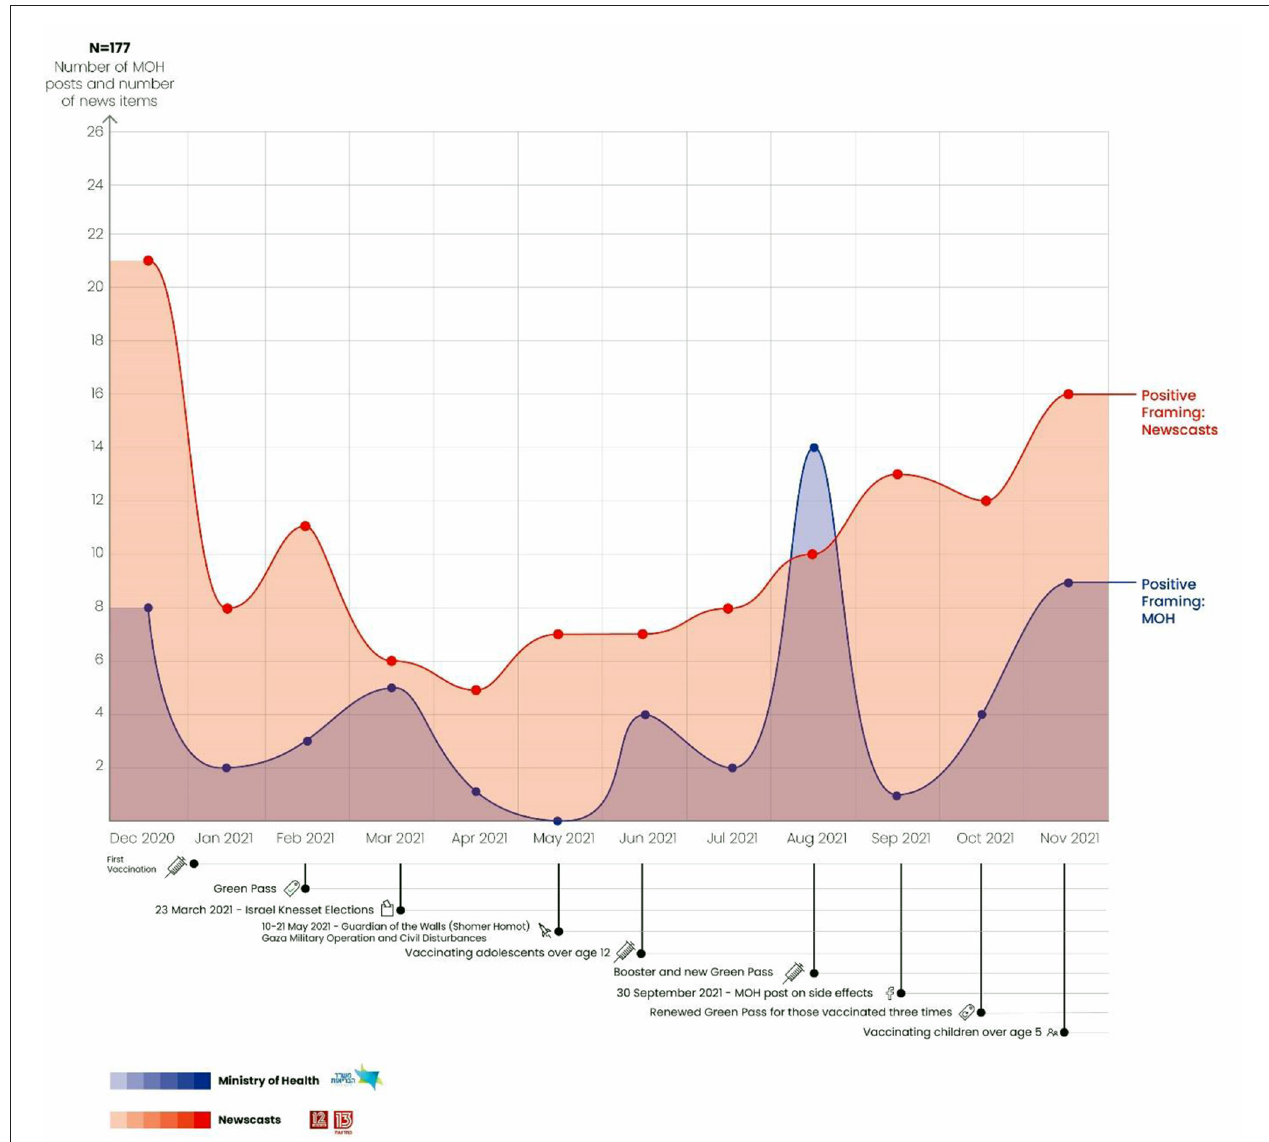
FIGURE 2 | Use of positive framing: Newscasts vs. Ministry of